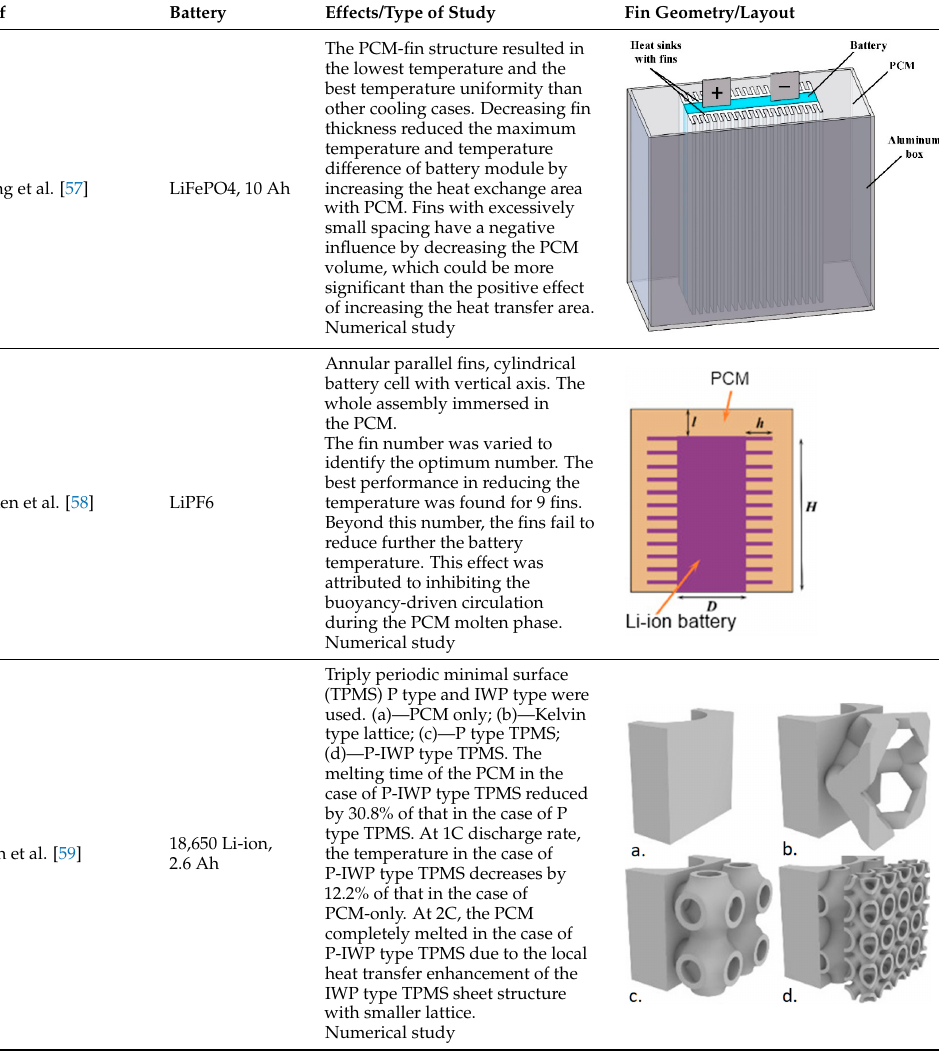
Table 3. Fin shapes and layouts for PCM-based BTMSs.